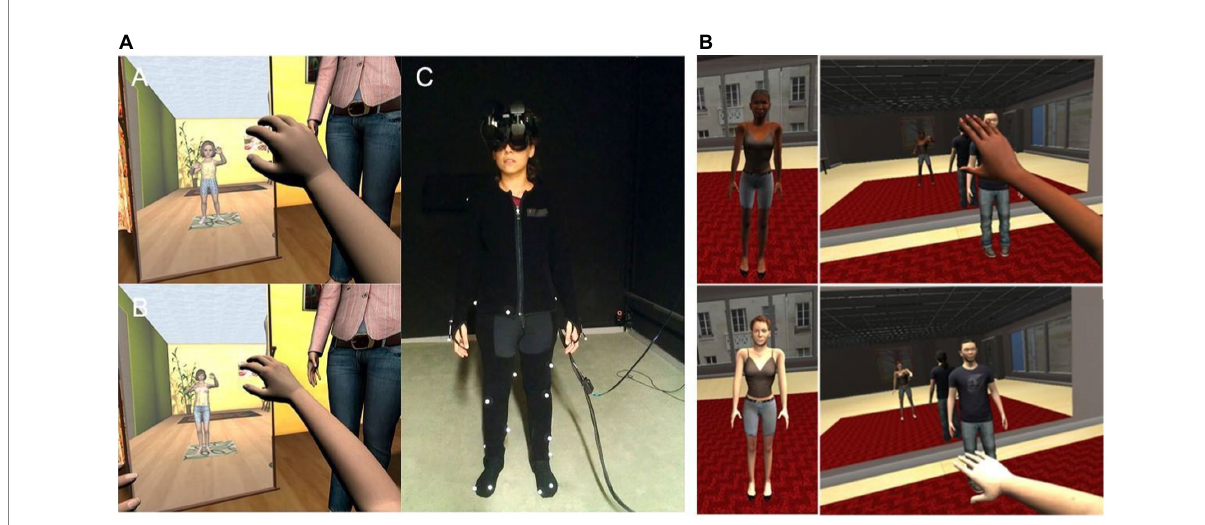
FIGURE 1 Embodiment in different bodies. (A) Screenshots of the child embodiment scene. A. From the first-person perspective of a virtual child. B. From the perspective of a virtual adult body shrunk to the same size as the child. C. Embodiment in a White or Black virtual body instructed to follow the movements of a Tai Chi teacher. (A) Source: Banakou et al. (2013). Reproduced with permission. (B) Source: Banakou et al. (2016) (CC-BY